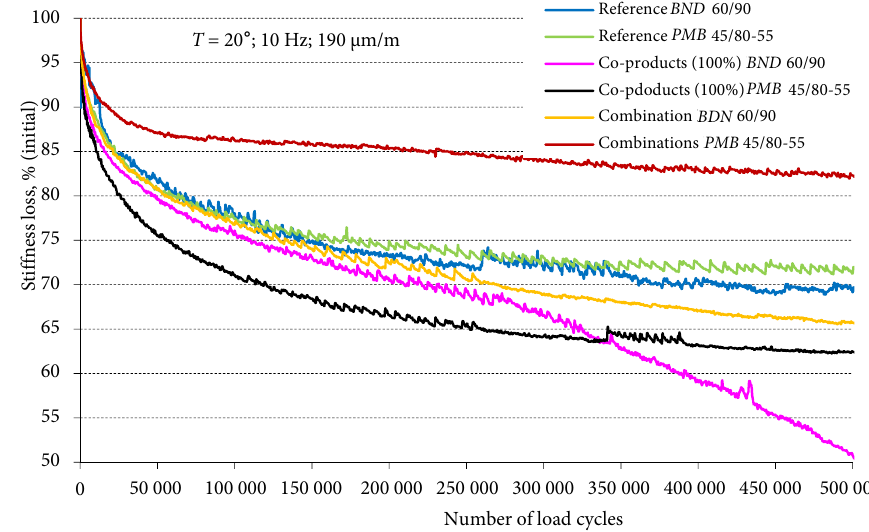
Fig. 7. Fatigue test